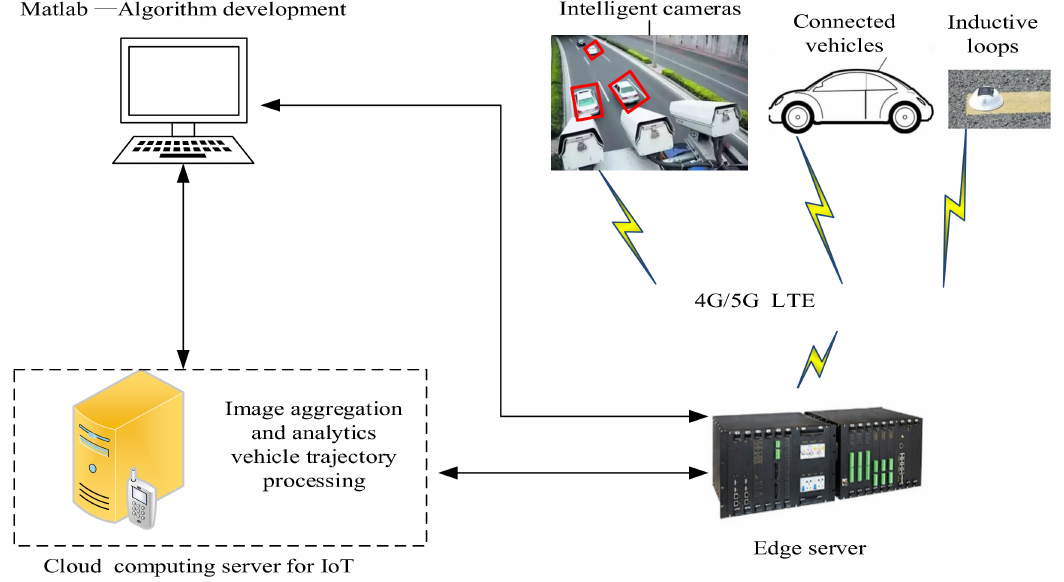
Figure 4. Structure of test for networking infrastructure-based tra ffi c information